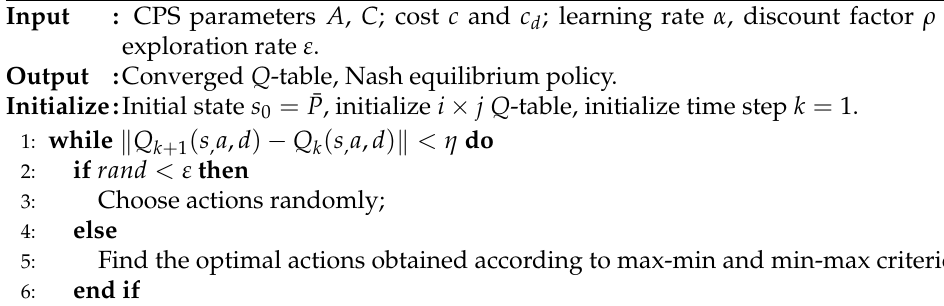
Algorithm 1 RL method to find Nash equilibrium